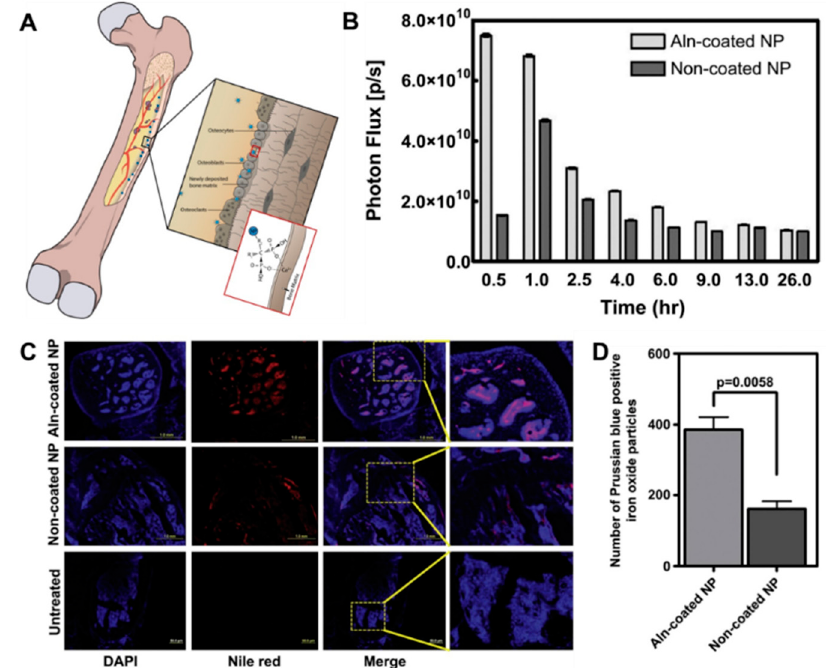
Figure 3. Active targeting of nanoparticles to bone using bisphosphonates. ( A ) Scheme showing targeting of bisphosphonate-functionalized NPs to bone. ( B ) Quantification of alendronate (Aln)-conjugated NPs accumulation into bone over time. ( C ) Representative image of Nile red-labelled NP localization in mouse femurs. ( D ) Quantification of number of NPs in the bone marrow. Reprinted with permission from Reference [96].